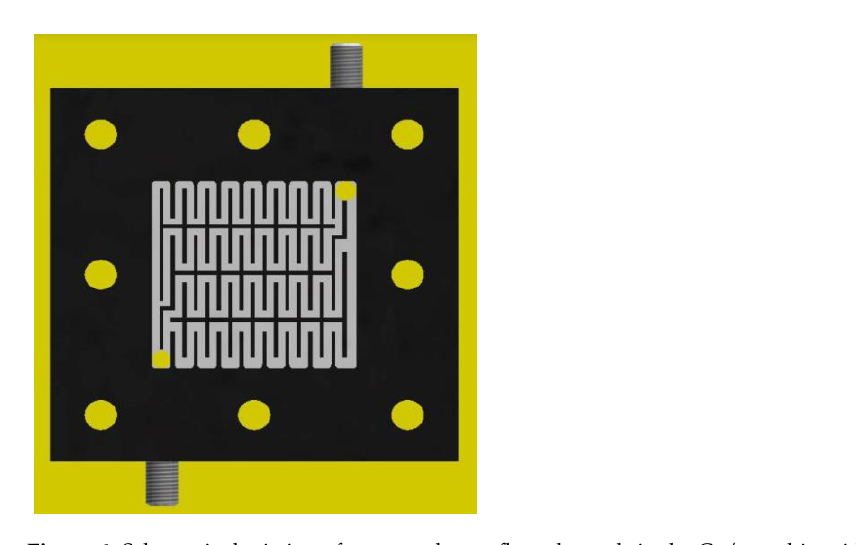
Figure 6 . Schematic depiction of staggered-type flow channels in the Ce/ascorbic acid/I RFB system